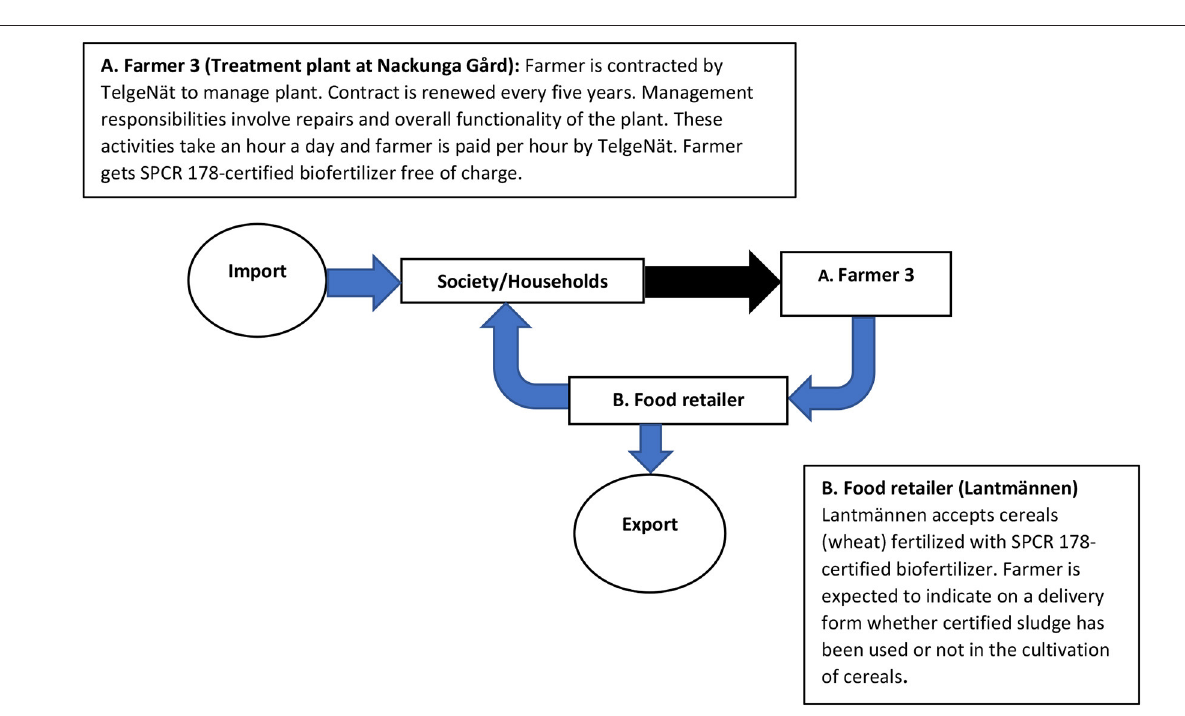
FIGURE 2 | Processes for SPCR 178-certified biofertilize—treatment plant to Farm and Farm to